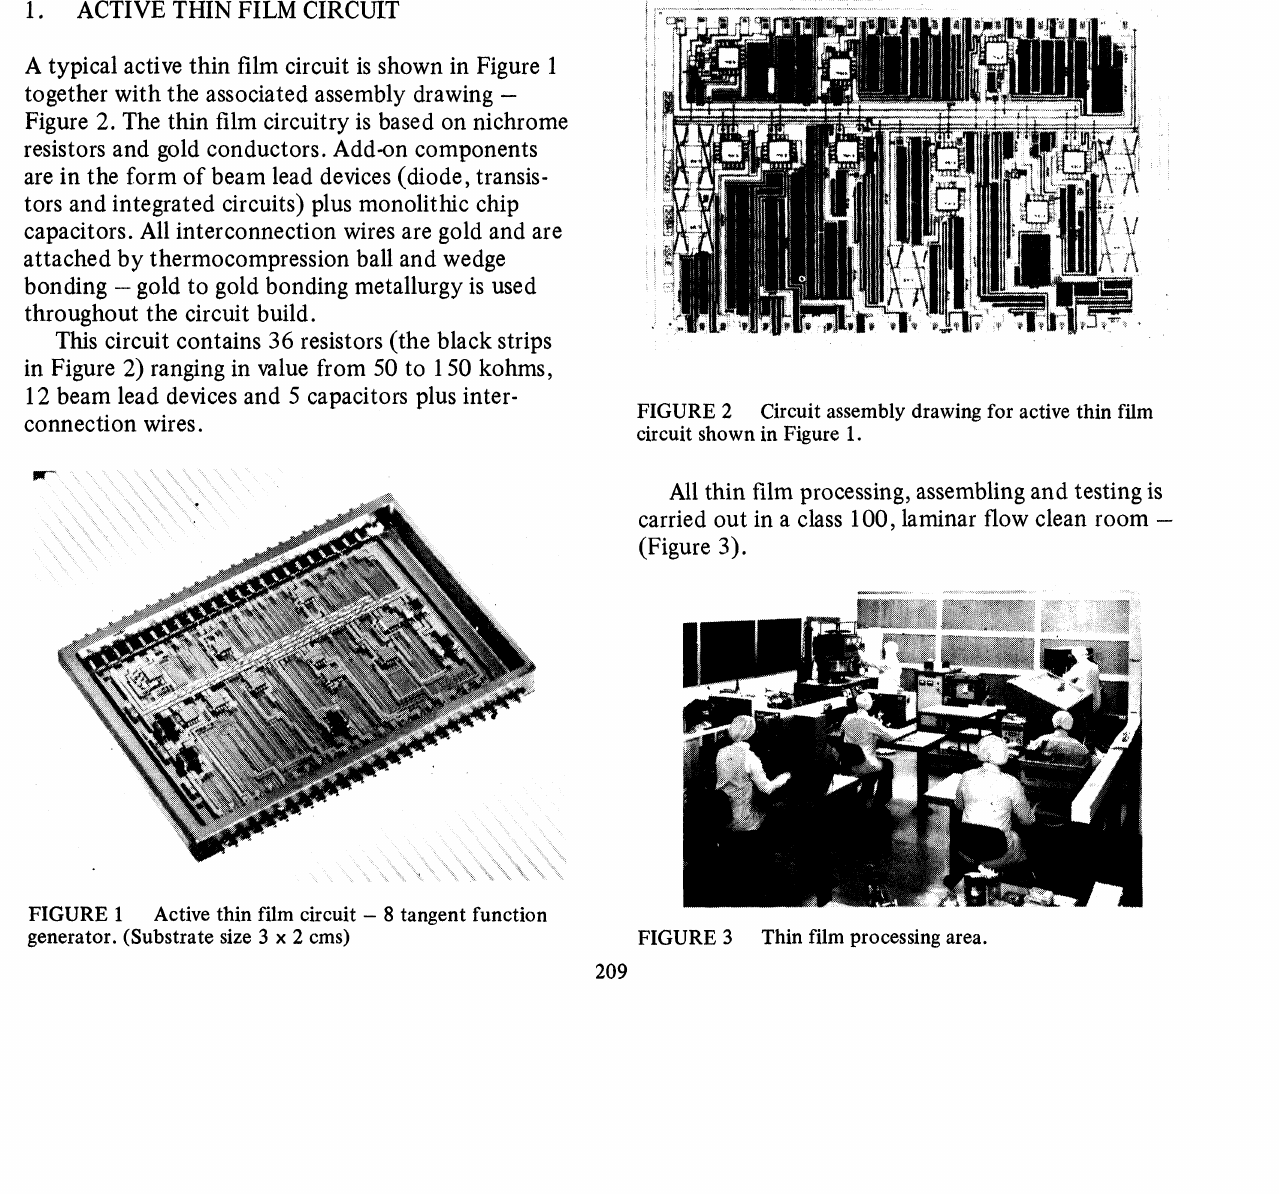
FIGURE Active thin film circuit 8 tangent function generator. (Substrate size 3 x 2 cms)